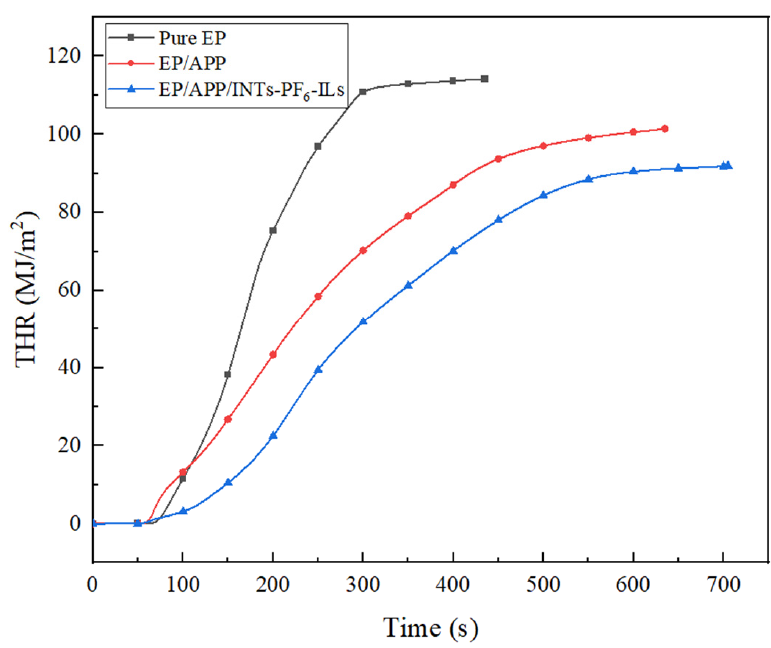
Figure 3. THR curves of EP composites.